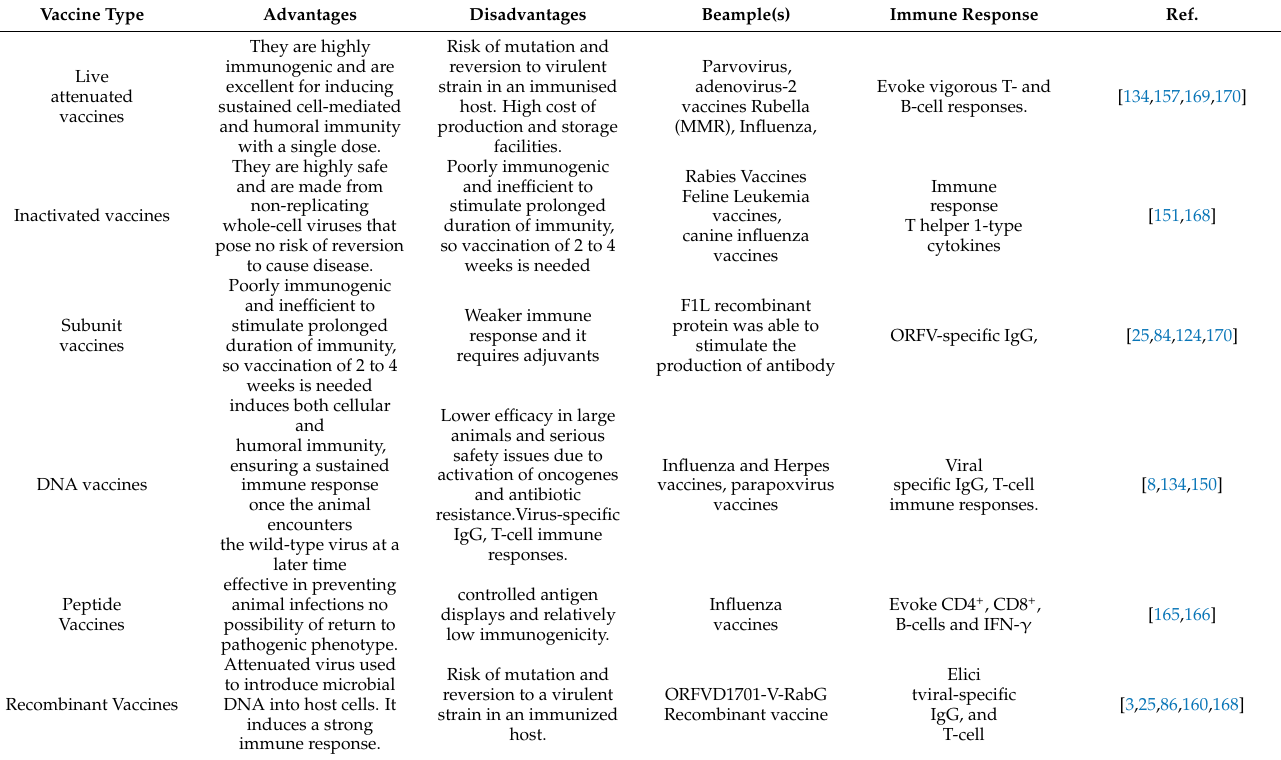
Table 2. Common viral vaccines of veterinary